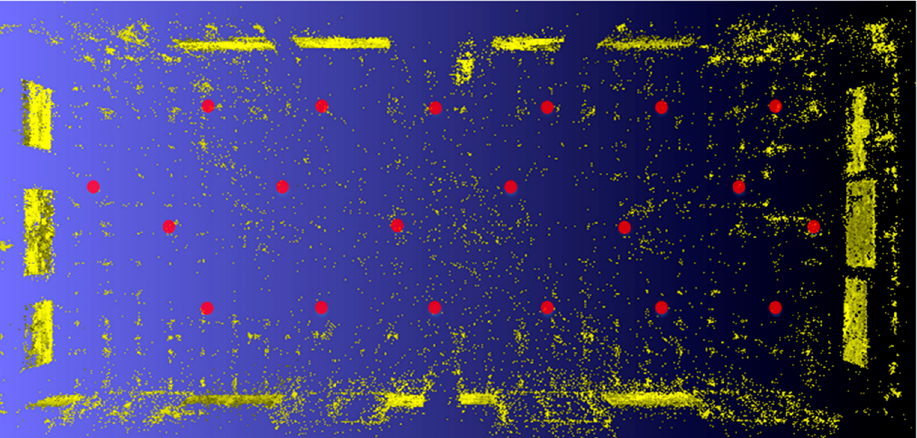
Figure 3. Three-dimensional object point cloud from multi-image spatial forward intersection.